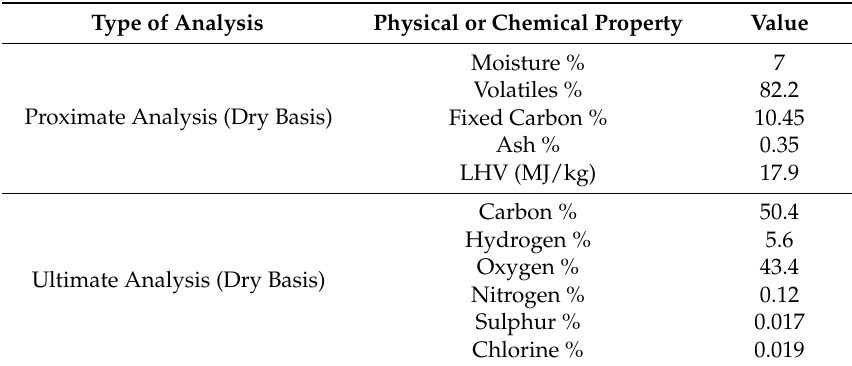
Table 1. Proximate and ultimate analysis results of Birchwood